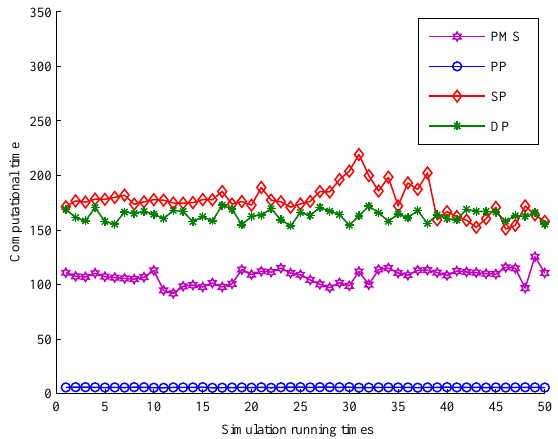
Figure 17. The comparison of four approaches in computation time